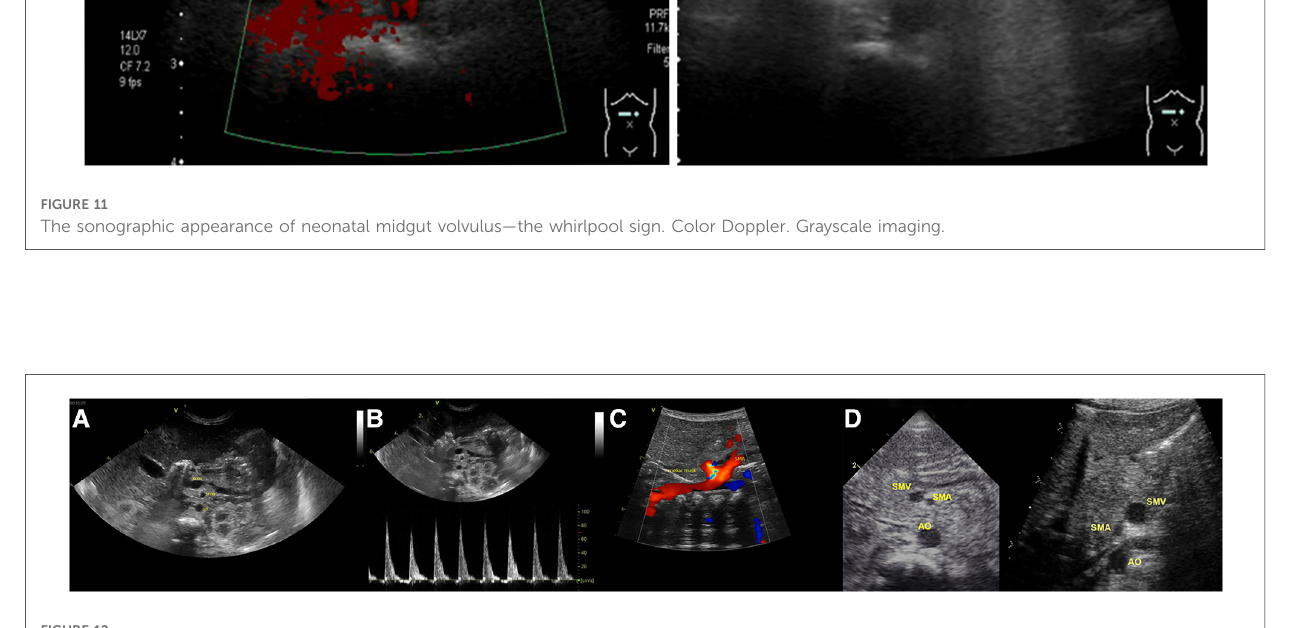
FIGURE 12 The sonographic appearance of superior mesenteric vessels — superior mesenteric artery (SMA) and the superior mesenteric vein (SMV) anatomical con fi guration. ( A ) Normal SMV and SMA relationship (SMV seen at 11 O ’ clock position to the SMA). ( B ) Arterial Doppler through the SMA con fi rming its anatomical location. ( C ) Sagittal image showing the relationship of the superior mesenteric artery to the aorta and the coeliac trunk. ( D ) Comparison of the normal (SMV seen at 11 O ’ clock position to the SMA) and abnormal positions (SMV seen at 01 O ’ clock position to the